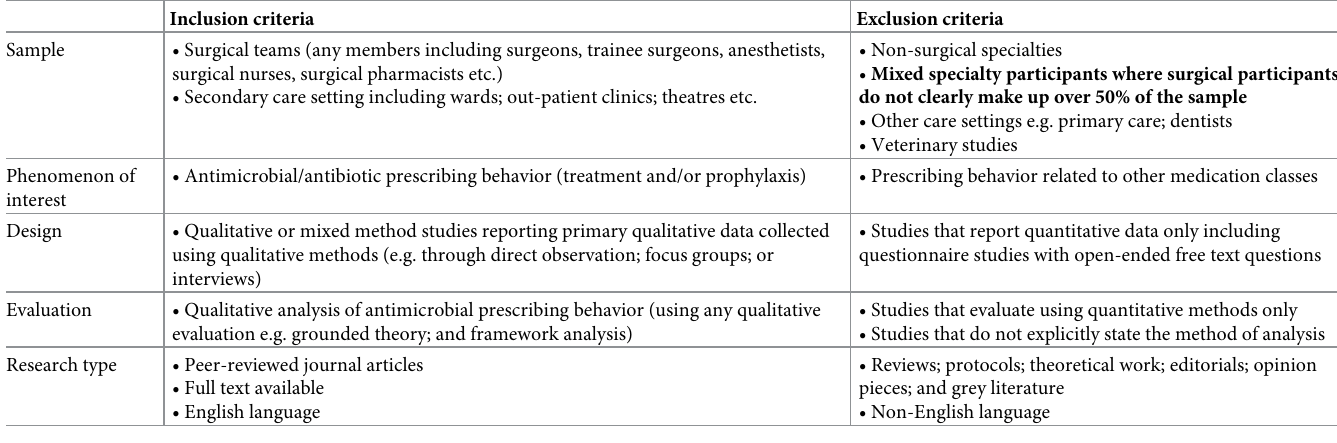
Table 2. SPIDER table of study inclusion and exclusion criteria [amended from Parker, Frost (44)] � .